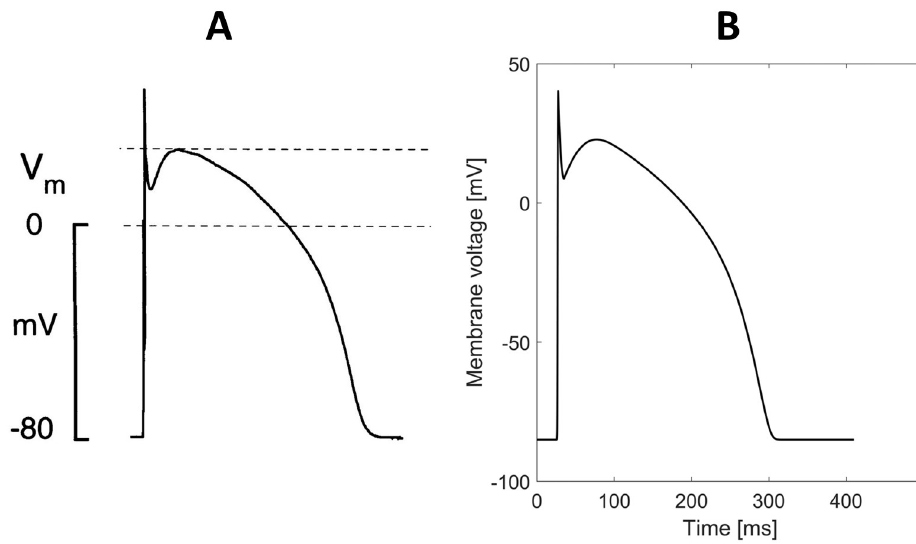
Fig 2. Comparison between simulated and experimental action potential. (A) Experimental action potential measured in human cardiac tissue by Nabauer et al. [20]. (B) Simulated action potential in one-dimensional cable.